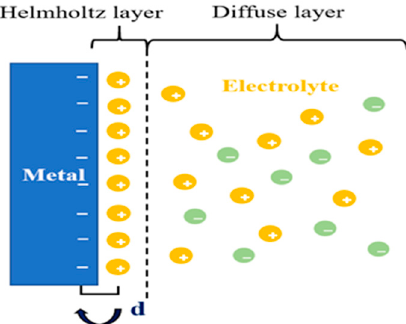
Figure 3. The double layers show the opposite charges equally distribute on both sides of the interface.